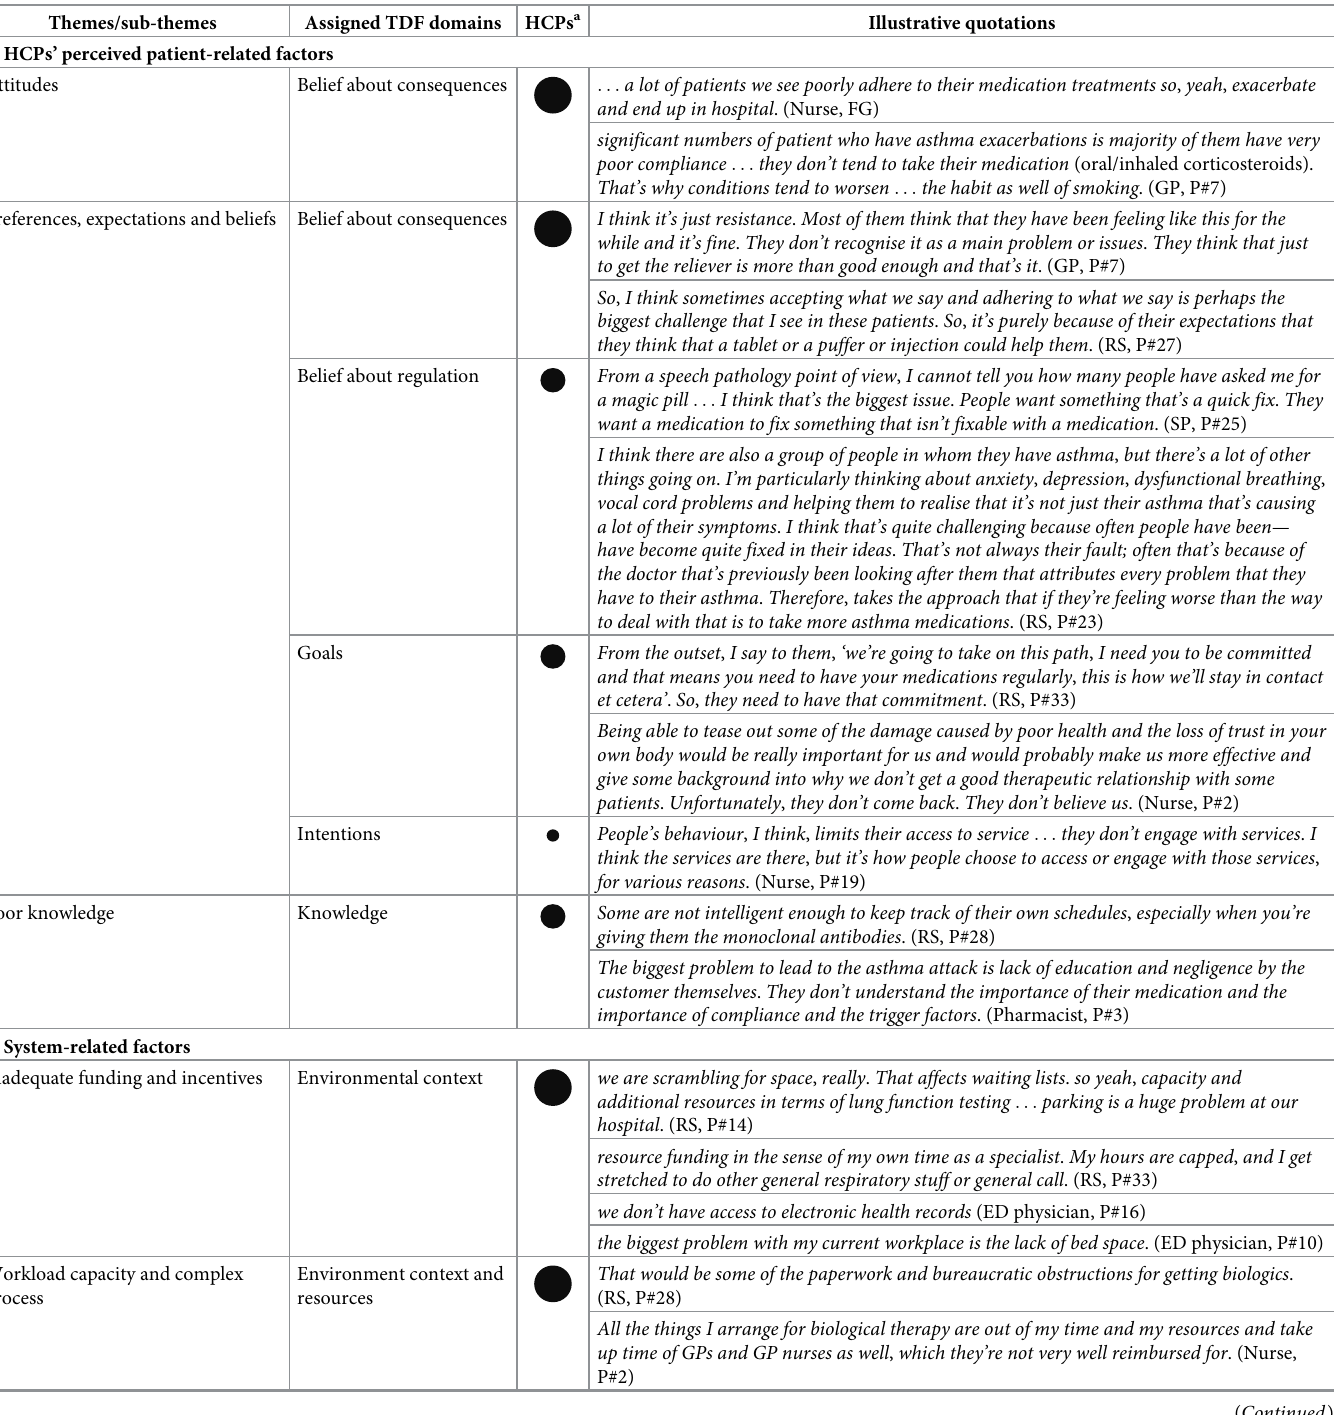
Table 3. Illustrative quotations regarding barriers to optimal management in severe